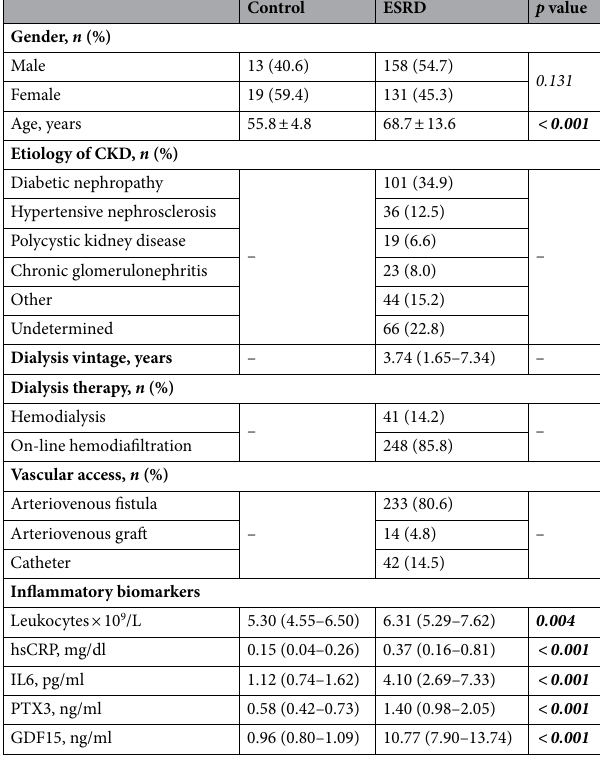
Table 2. Demographic, clinical and inflammatory data for Controls ( n = 32) and ESRD patients on hemodialysis treatment ( n = 289). Data are presented as mean ± standard deviation or as median (interquartile range). Multiple comparisons between groups were performed by the Pearson’s Chi-squared test, by the one-way Anova with Bonferroni post-hoc tests or by the Mann–Whitney U test, as appropriate. Italic denotes p- values and bold-italic statistically significant p- values. CKD chronic kidney disease, GDF15 growth differentiation factor 15, hsCRP high-sensitivity C-reactive protein, IL6 interleukin 6, PTX3 pentraxin 3.